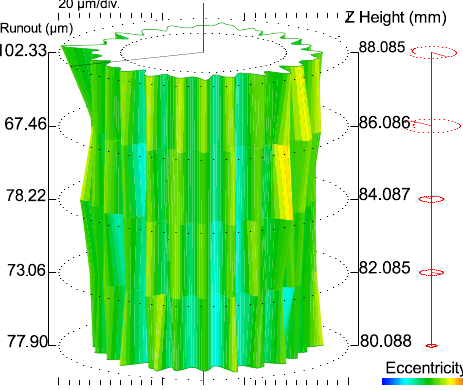
Figure 7. Determining the cylindricity of the tool shank.